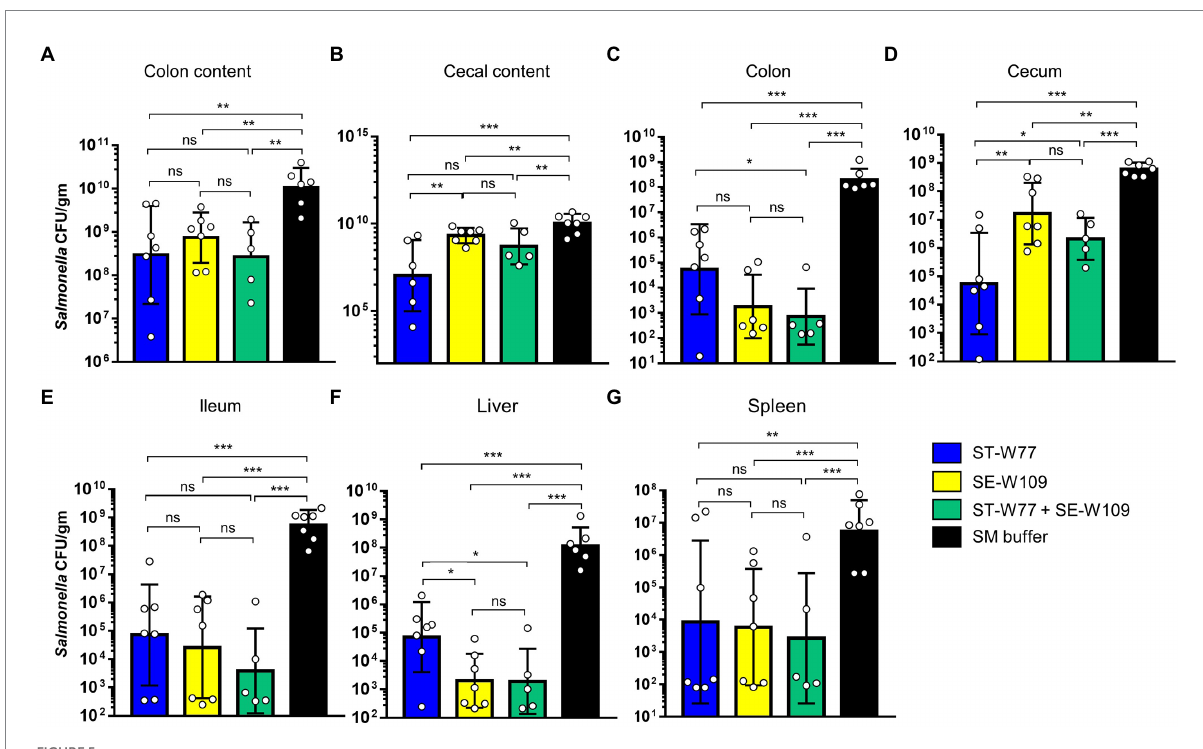
FIGURE 5 Both phages ST-W77 and SE-W109 significantly decreased S. Tm numbers in mouse gastrointestinal tract and systemic sites. All mice were orally fed with streptomycin sulfate 1 day prior to S. Tm infection (10 8 CFU/mouse) and treated with phages (10 10 PFU/mouse) for three consecutive days. On day 4 p.i., all mice were euthanized tissues were collected to detect Salmonella numbers in each tissue (CFU/gm) by a plating method. Numbers of S. Tm in the gut lumen (A,B) , local gut tissues (C-E) , and systemic tissues (F,G) were investigated. Bars represent the geometric mean; error bars indicate geometric standard deviation.*, **, *** indicated p < 0.05, 0.01 and 0.001, respectively. ns, a non-statistically significant